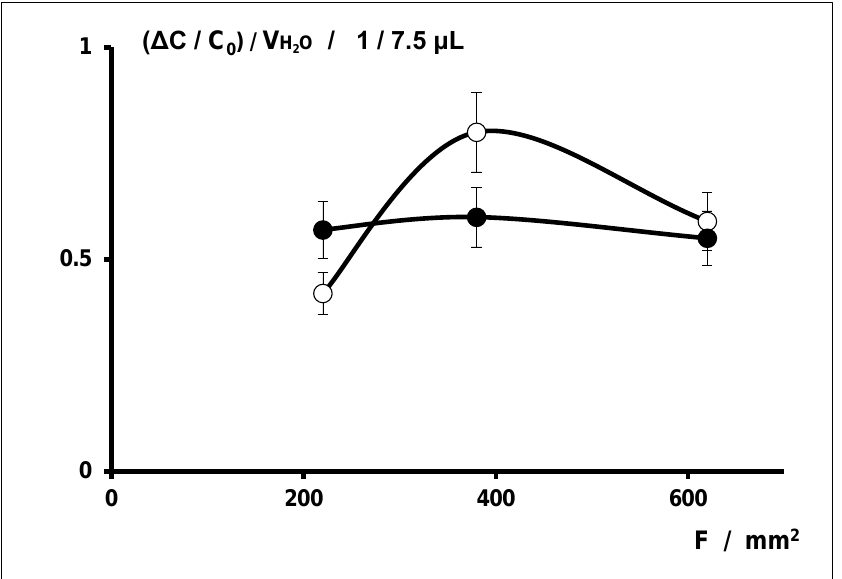
Figure 3. Relative water-specific change in electrical capacitance (ratio of the relative change in electrical capacitance to the causal change in water volume (ΔC/C 0 )/V H 2 O of dressing samples in series Fx as a function of the sensor area F (= L ∙ B). Sensor wire diameter d = 0.071 mm, stitching spacing b = 0.5 mm; Sensor wire spacing, a = 0.5 mm—black, a = 1 mm—white.